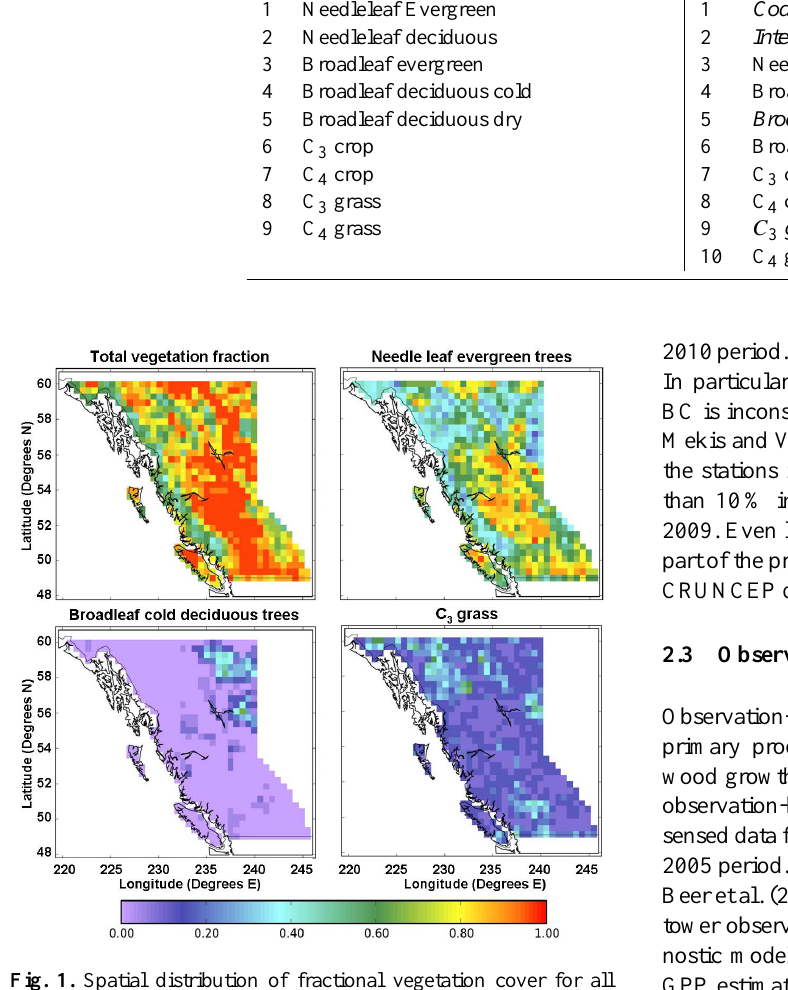
Fig. 1. Spatial distribution of fractional vegetation cover for all PFTs and for needleleaf evergreen trees, broadleaf cold deciduous trees and C 3 grass